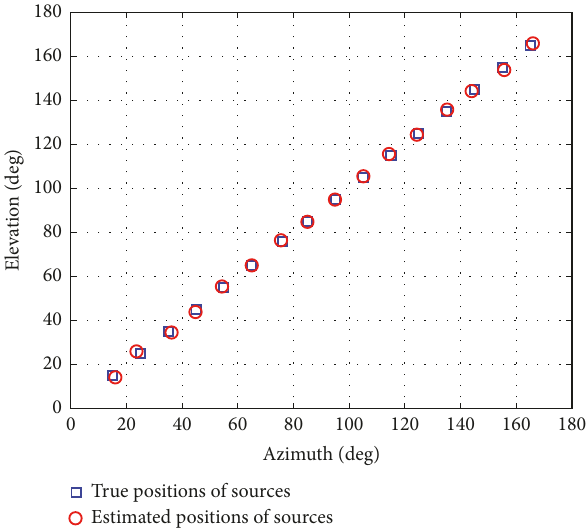
Figure 3: Estimation for 2D ID sources with different APDF. is applied for the evaluation of the performance of estimation.